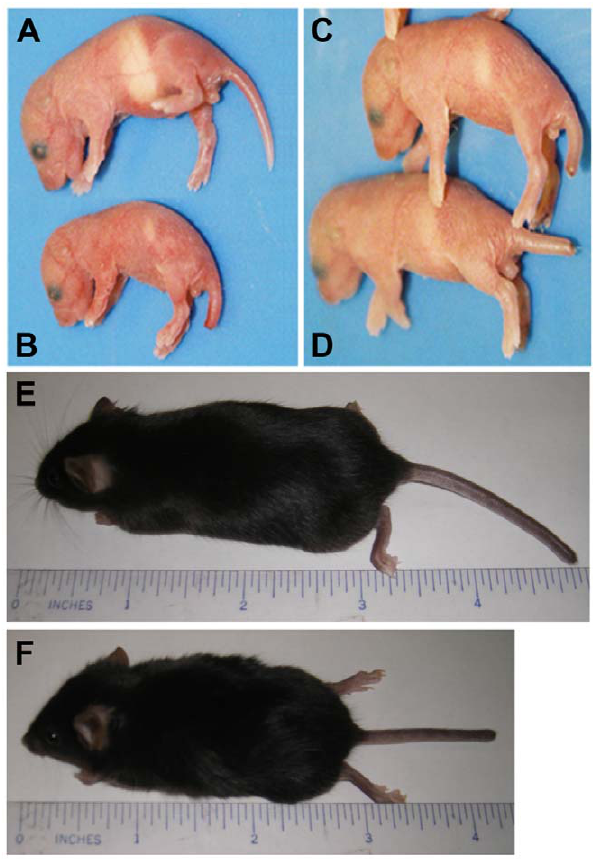
Figure 2. Rescued Lamc2 KO mice appear normal at birth and live to adulthood. Images of newborn Lamc2 Het (A), Lamc2 KO (B), rescued Lamc2 KO (C), and Lamc2 WT (D), and adult Lamc2 WT (E) and rescued Lamc2 KO (F) are shown. Newborn Lamc2 KO mice are occasionally smaller, have blistered feet (arrow), and a smaller milk pouch (B). Lamc2 KO mice that carry both the K14-rtTA and TetO- HuLamC2 transgenes (C) look similar to littermate controls (A and D). Rescued Lamc2 KO mice live to adulthood (F) and have similar length and weight as Lamc2 WT littermates (E).